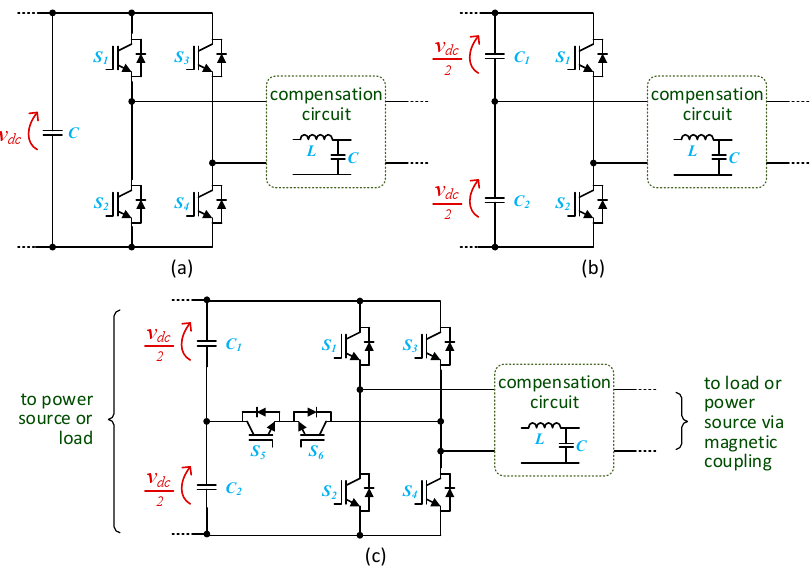
Figure 14. Main power electronics topologies used in IWPT, both in primary side and secondary side: ( a ) full-bridge converter; ( b ) half-bridge converter; ( c ) multilevel topology.